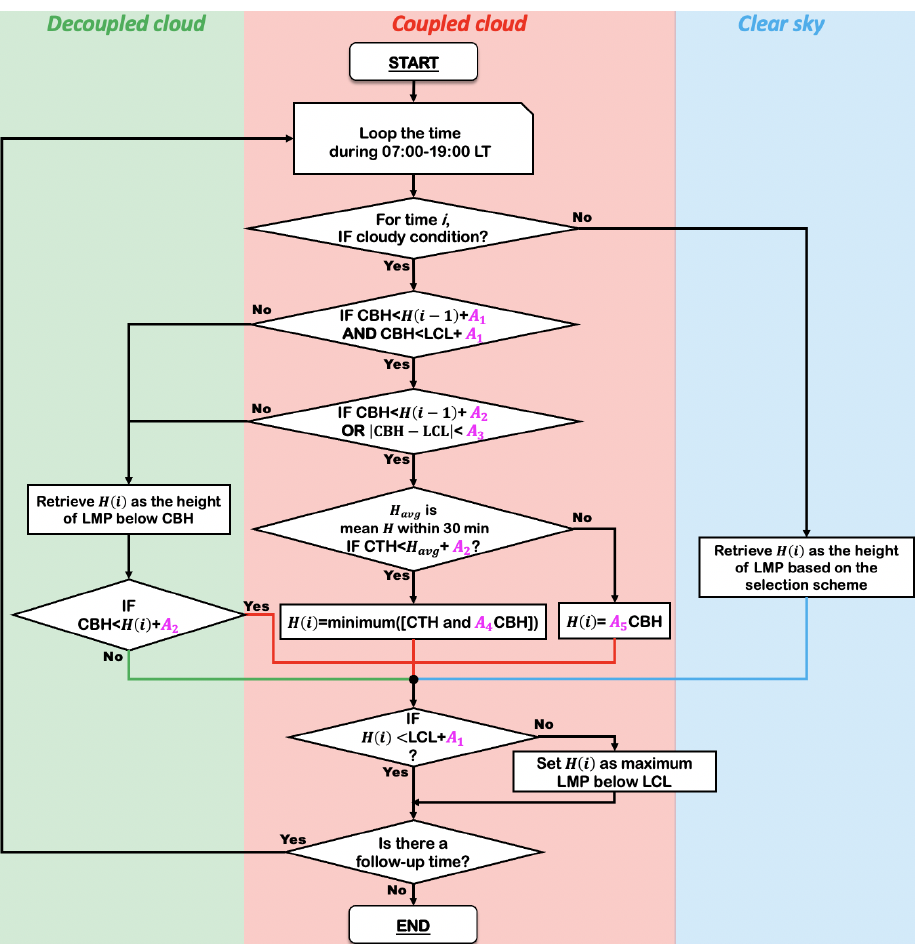
Figure 4. The flowchart of the updated DTDS algorithm. In this diagram, H ( i ) is the retrieved planetary boundary layer height (PBLH) at time i . CBH and CTH represent the base and top heights, respectively, of the lowest cloud at time i . The PBLH part for selecting the suitable local maximum position (LMP) follows Su et al. (2020), and a detailed scheme for identifying a coupled cloud is added to the DTDS algorithm. LCL stands for lifted condensation level. Five empirical parameters ( A 1 , A 2 , A 3 , A 4 , and A 5 ) are set as 0.7, 0.2, 0.15, 1.35, and 1.1,